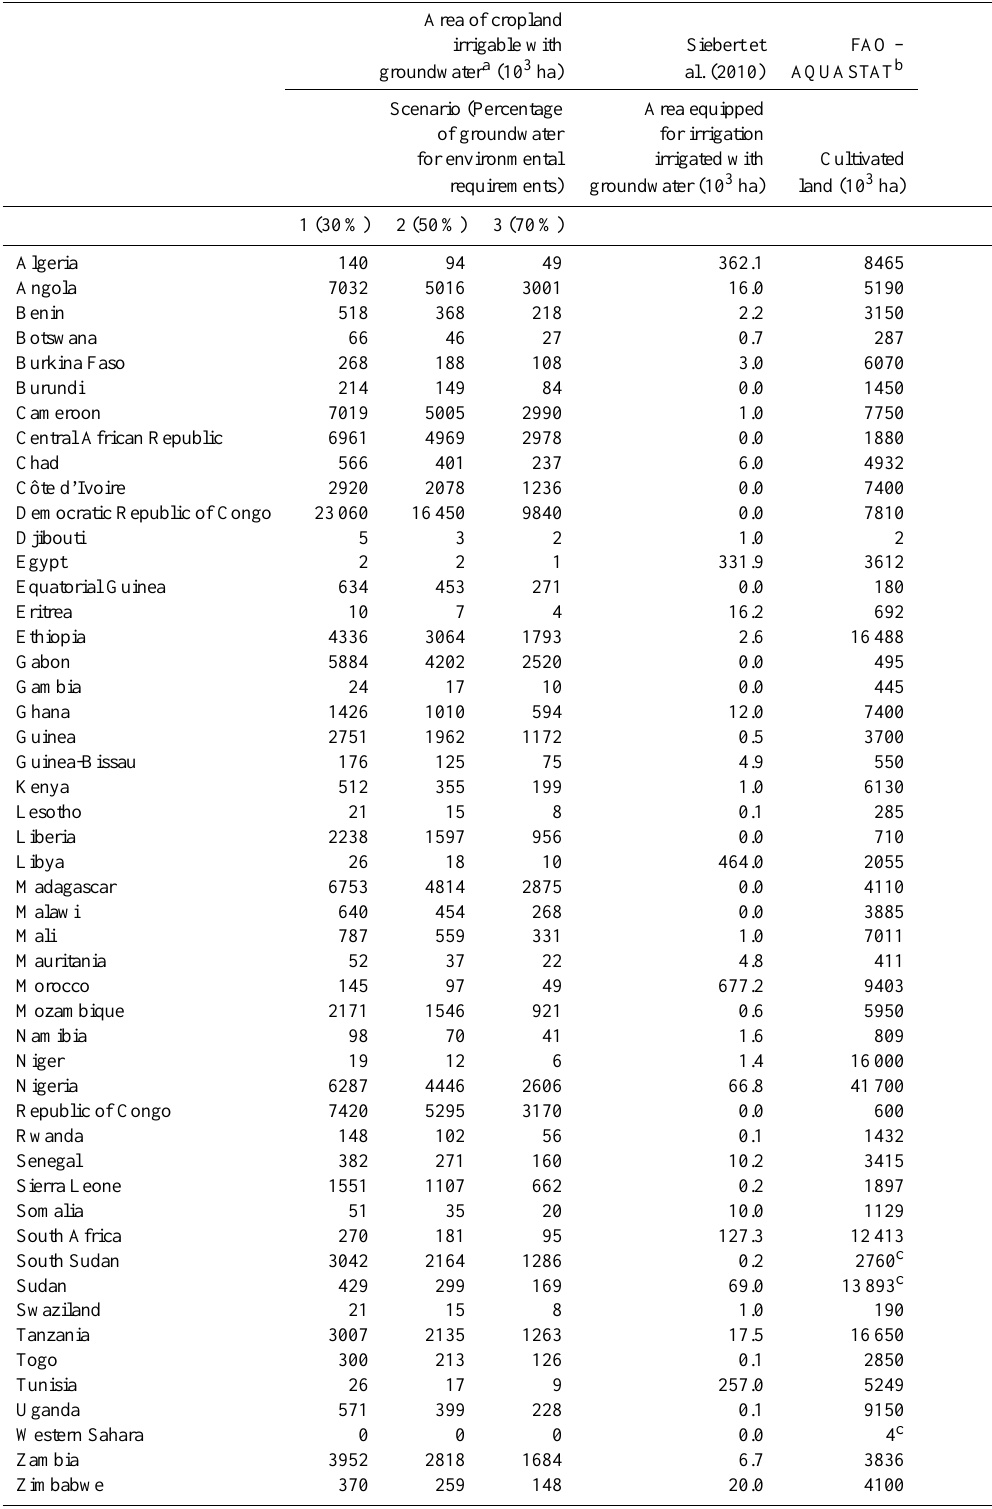
Table 4. Gross groundwater irrigation potential and cultivated area per country in